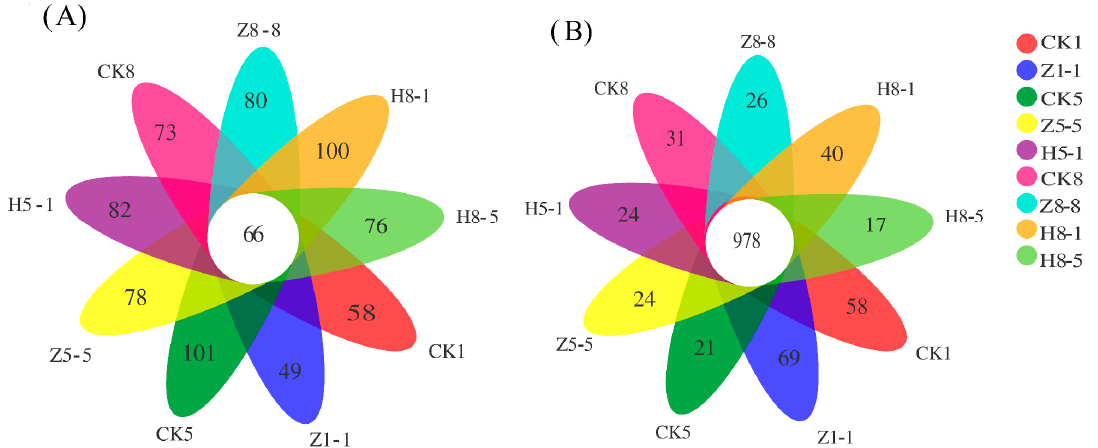
Figure 3. Quantity of OUTs in the soil microbial community in different years of growing and replanting. Note: The nomenclature for each sample is the same as that in Table 2. ( A ) Changes in OTUs quantity of fungi; ( B ) Changes in OTUs quantity of bacteria.